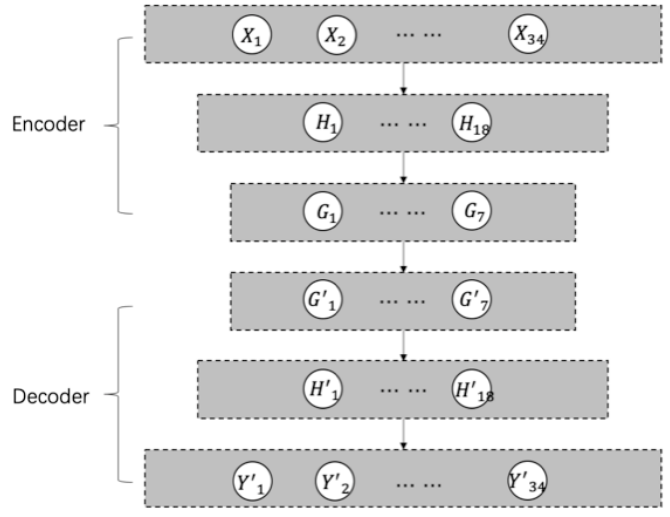
Figure 5. The architecture of the autoencoders.